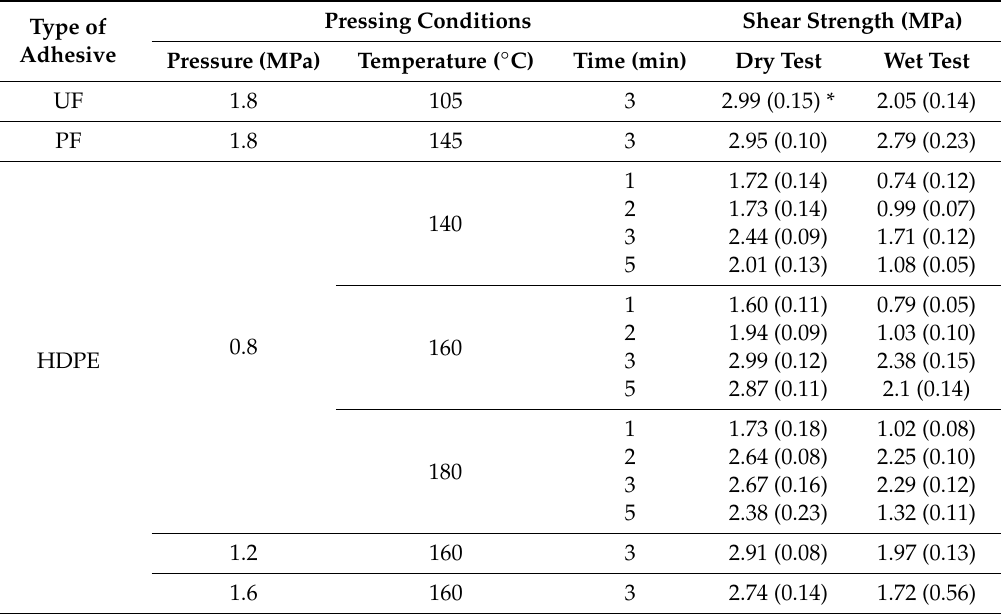
Table 5. Shear strength values of plywood panels pressed using different types of adhesive and pressing conditions.